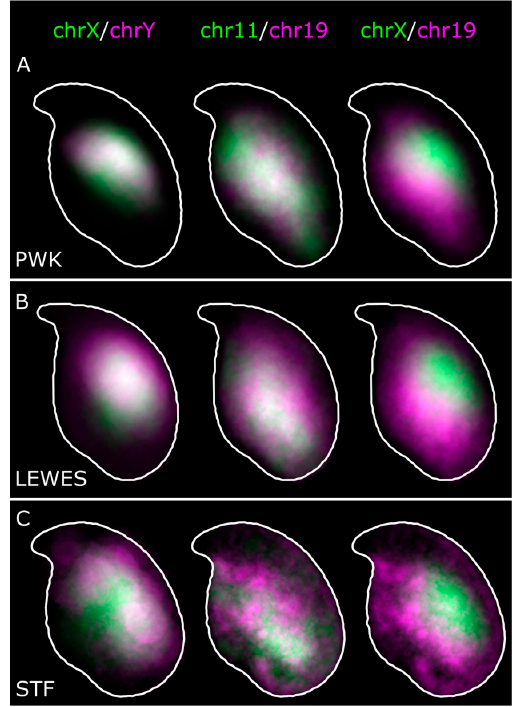
Figure 3. Composite signal distributions for chromosomes X, Y, 11 and 19 in ( A ) PWK, ( B ) LEWES and ( C ) STF. The sex chromosomes occupy a consistent territory apical and dorsal to the centre of mass, generally under the acrosome but rarely extending fully to the periphery of the nucleus. Chromosomes 11 and 19 are more widely distributed, with the predominant location basal and ventral to the centre of mass.